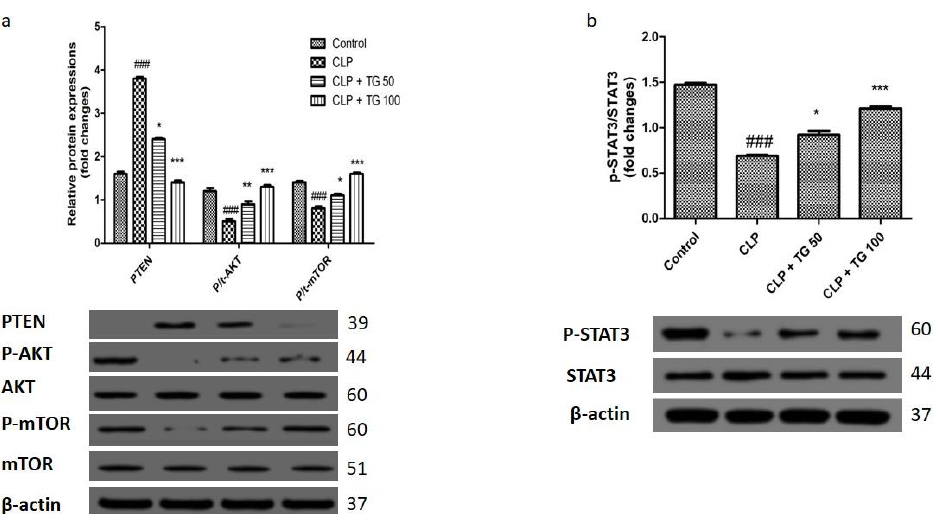
Figure 10. Effect of TG (50 and 100 mg/kg) on myocardial autophagy-related signal pathways and STAT3. ( a ) Treatment with TG (50 and 100 mg/kg) inhibits myocardial autophagy-related signal pathway PTEN/AKT/mTOR. ( b ) Treatment with TG (50 and 100 mg/kg) suppressed the expression of STAT3 in cardiac tissues. Values represented as means ± SDand n = 12/group. One-way analysis of variance (ANOVA), followed by Tukey’s test were used for statically analysis (Significance level * p < 0.05). Where ### p < 0.001 compared with control group, whereas ** p < 0.01 and *** p < 0.001 when compared with CLP group animals.